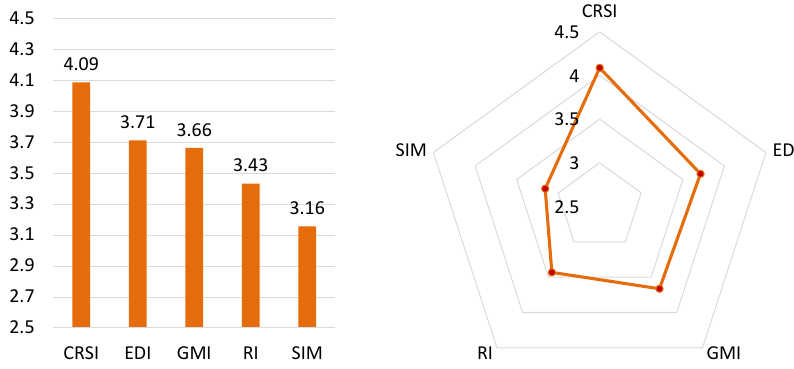
Figure 18. BIM-GIS model integration level survey results.